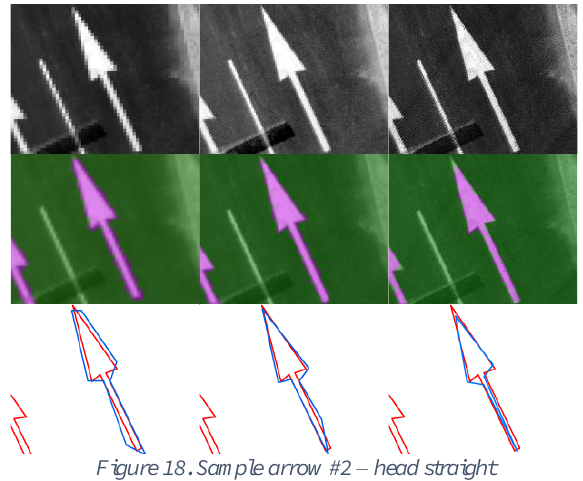
Figure 18. Sample arrow #2 – head straight (intensity-based).